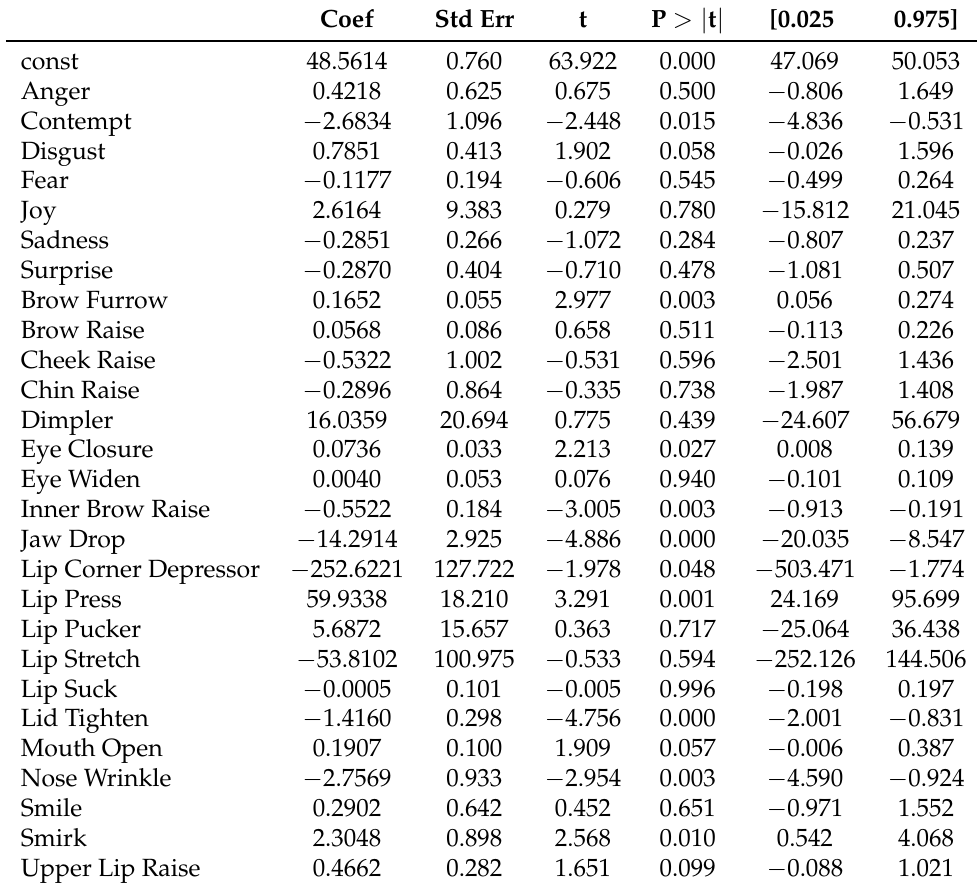
Table 2. Ordinary least squares regression results.